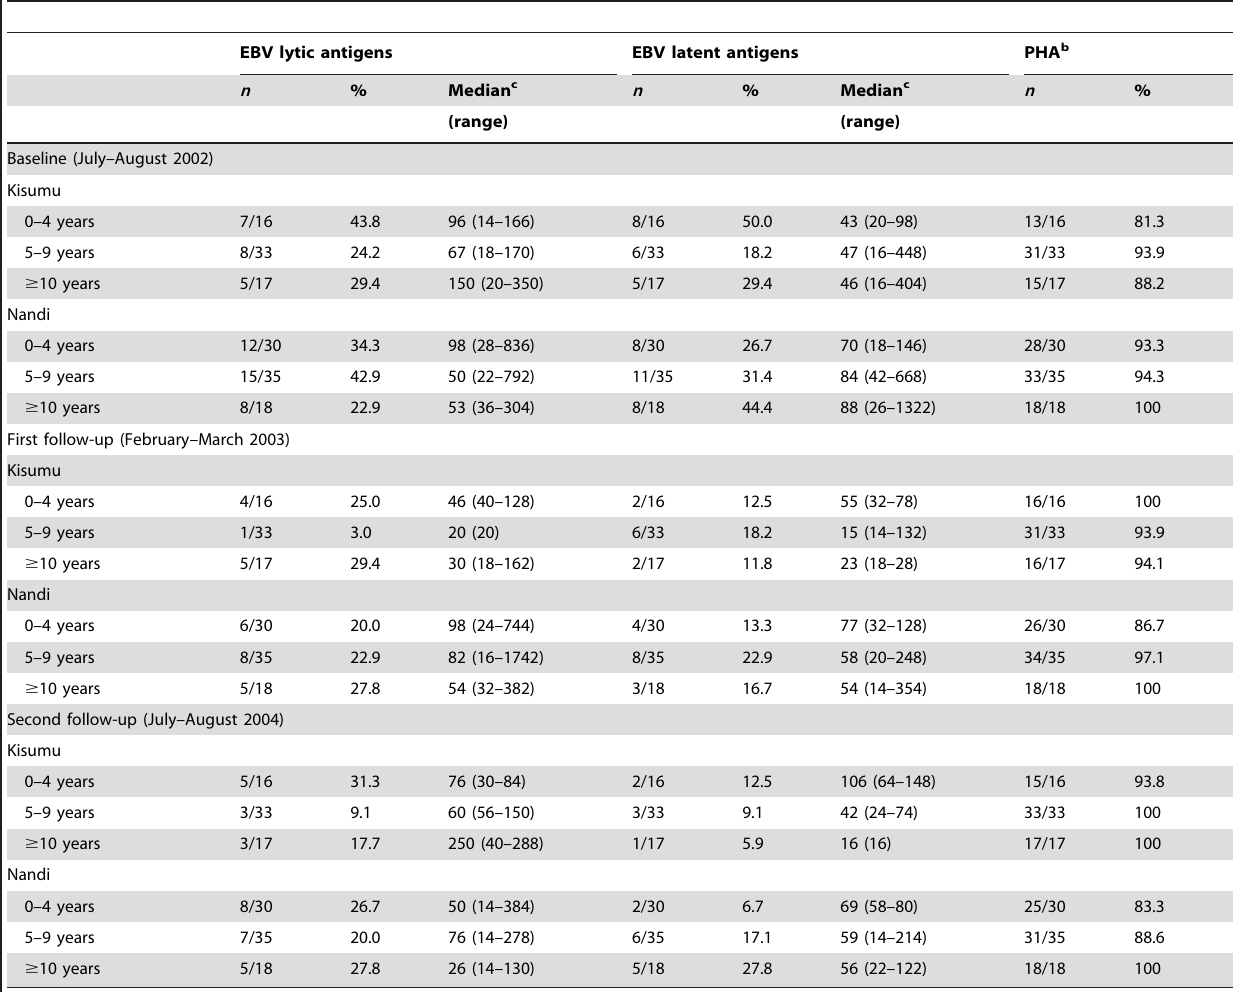
Table 2. EBV-specific CD8 + T-cell IFN- c Response by Residence and Age Group a